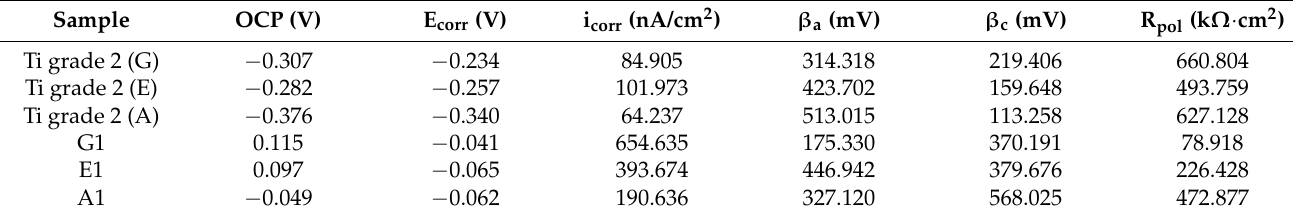
Figure 8. ( a ) Open circuit potential (OCP); ( b ) potentiodynamic polarization curves; ( c ) Nyquist plots; and ( d ) Bode plots of the surface of pre-treated Ti grade 2 substrates and samples with chit/EE100 coatings. Table 5. Open circuit potential (OCP); corrosion potential (E corr ); current density (i corr ); Tafel slope values ( β a and β c ); and polarization resistance (R pol ) of the investigated